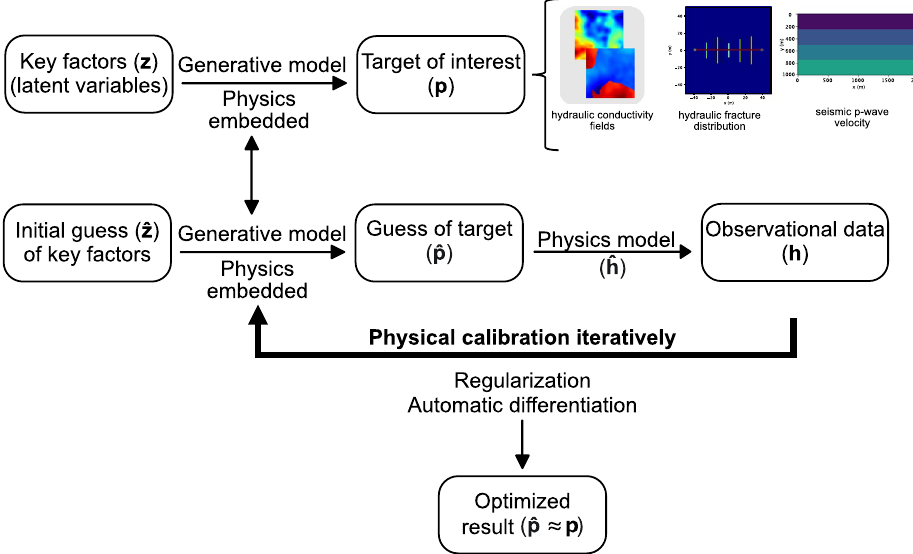
Figure 1. Physics-embedded inverse analysis leverages the underground geological property characterization with physics law understanding and algorithmic differentiation. Inverse properties are calculated based on the physics-embedded generative model, and calibration is performed on the output of the forward model. The first row characterizes the “true” situation in the field, and the generative model describes the physics understanding of the problem. This generative model is applied in the inverse analysis (second row) to represent the physics- embedded feature. The application of regularization and algorithmic differentiation makes the optimization process